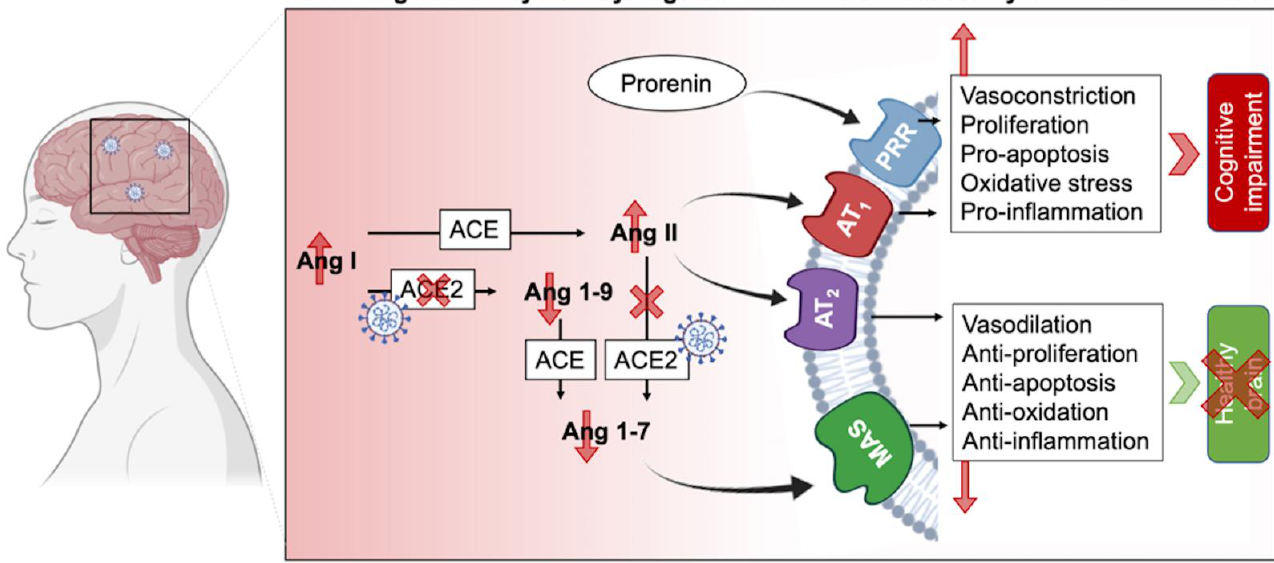
Figure 2. Schematic of RAS impairment in the brain during SARS-CoV-2 infection. ACE: Angio- Schematic of RAS impairment in the brain during SARS-CoV-2 infection. tensin-converting enzyme; Ang: Angiotensin; AT1R: Angiotensin II receptor type 1; AT2R: Angio- ACE: Angiotensin-converting enzyme; Ang: Angiotensin; AT1R: Angiotensin II receptor tensin II receptor type 2; MAS: Mas-related G protein-coupled receptors, PRR: Prorenin receptor.